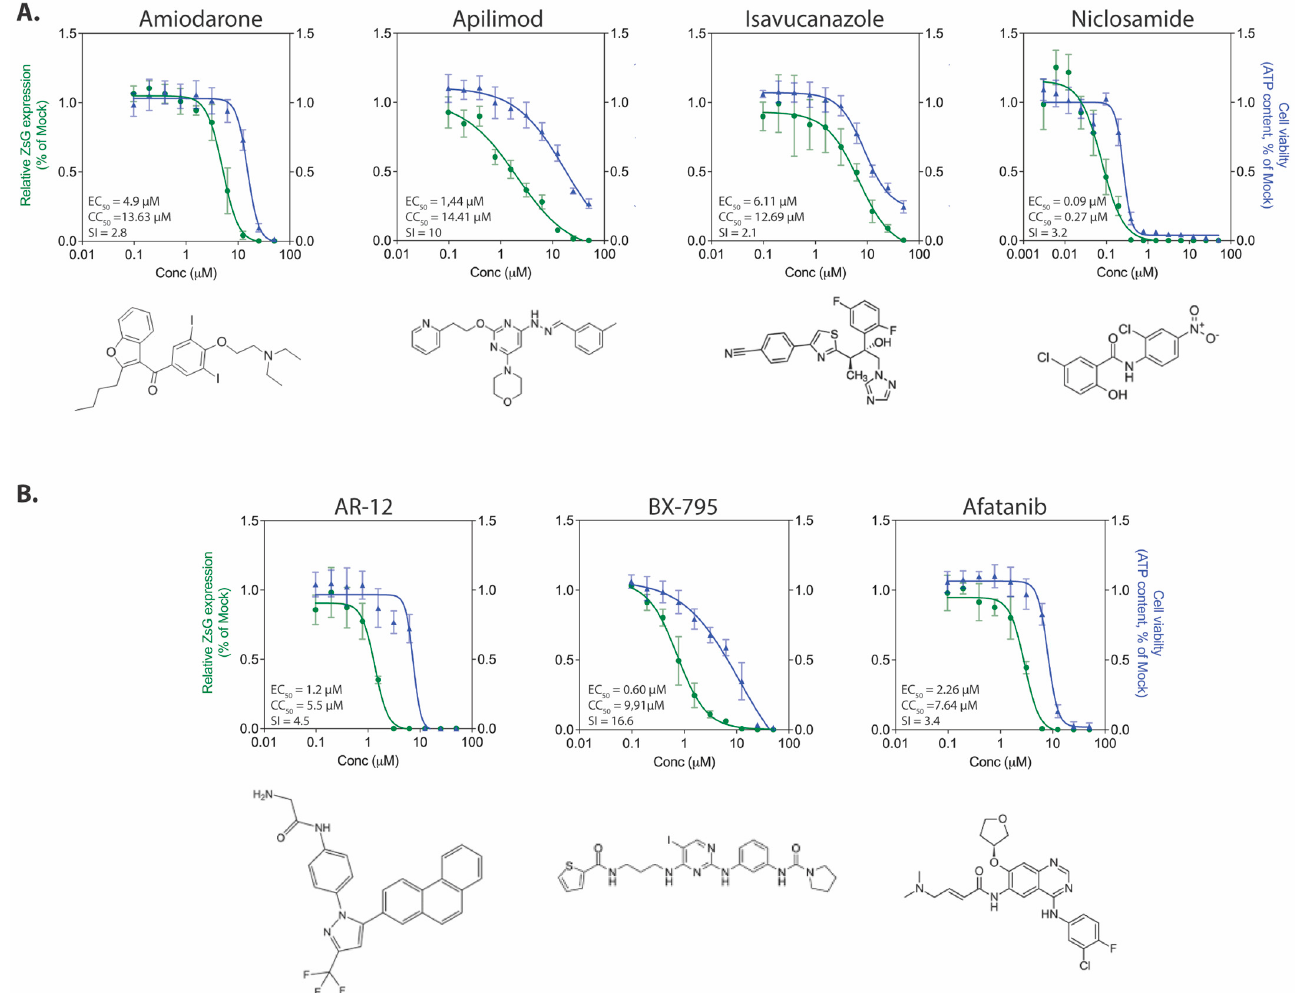
Figure 3. Antiviral activity of select protein kinase inhibitors and known entry inhibitors. Concentration-response curves in Huh7 cells infected with rLUJV/ZsG (MOI 0.1) after being treated 1 h prior with ( A ) compounds known to block arenavirus entry, egress, or intracellular tracking processes; or ( B ) protein kinase inhibitors. Relative ZsG expression is shown in green and cell viability is shown in blue. Values were normalized to mock-treated (DMSO only) infected cells. Each point represents the mean of quadruplicate wells, with error bars indicating standard deviation; graphs are representative of at least 3 independent experiments. Associated EC 50 , CC 50 , and SI values are provided along with the chemical structure of each compound.